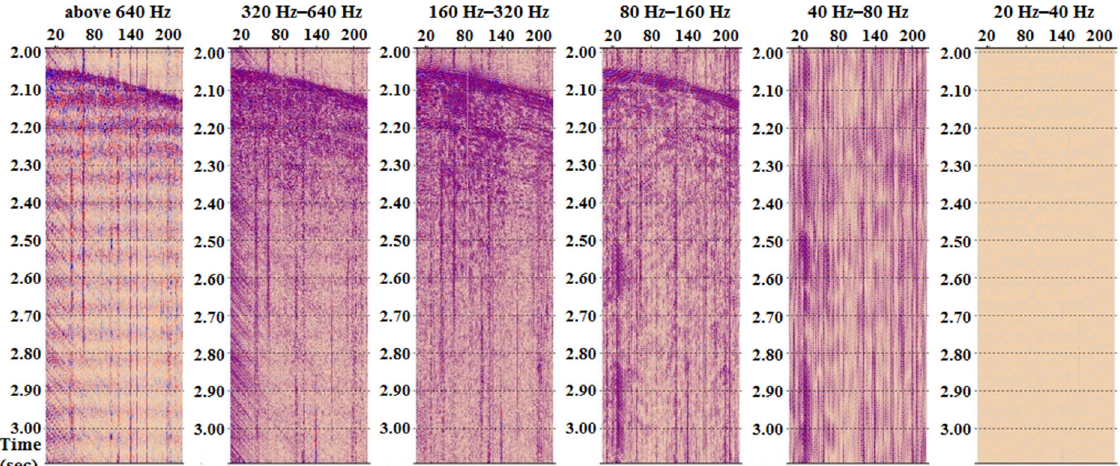
Figure 8. Spectrum scanning diagram of a single shot.